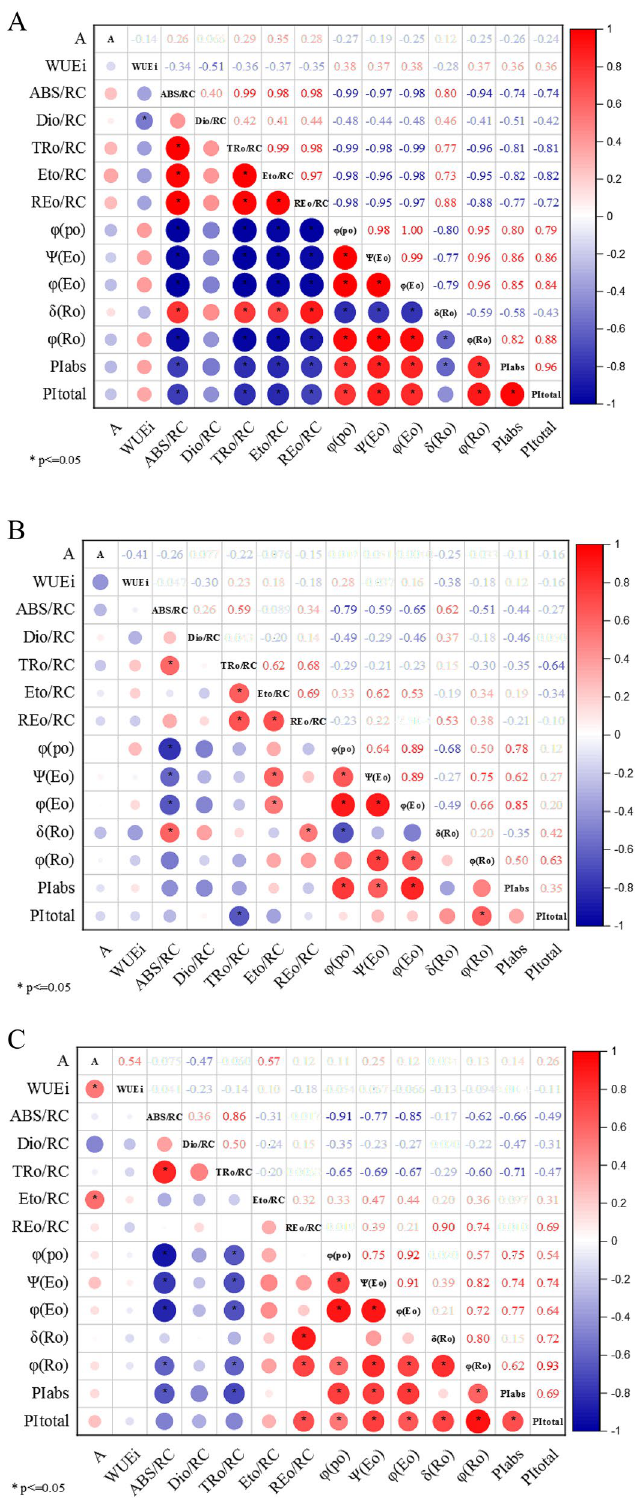
Figure 7. Correlation plot between the plant gas exchange ( A , WUE i ) and prompt fluorescence parameters. ( A ) In control conditions (non-stressed plants); ( B ) under salt stress; ( C ) under alkalinity stress. The size and color intensity of circles are proportional to Pearson’s correlation coefficient at p < 0.01. Red circles indicate positive correlations, while blue are negative correlations. In the correlogram scale from −1 to + 1, Pearson’s correlation coefficient for variables is on the vertical and horizontal axis. Asterisk indicates values that are statistically different at p < 0.05. The correlation plot was drawn with Origin Pro software version 2021 (https:// www. origi nlab. com/